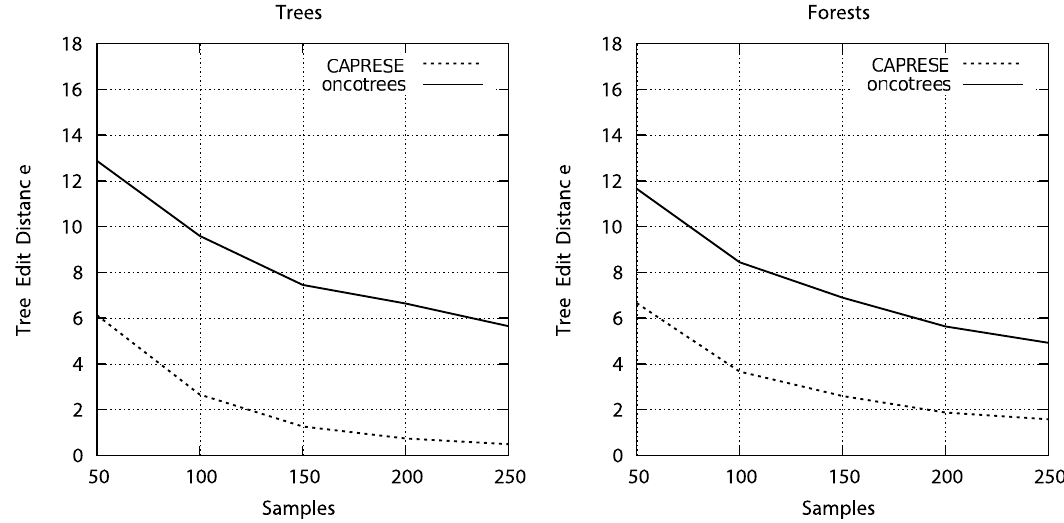
Figure 4. Comparison on noise-free synthetic data. Performance of CAPRESE (dashed line) and oncotrees (full line) in average TED when data are generated by random trees (left) and forests (right). In this case n ~ 0 (no false positives/negatives) and l ? 0 in the estimator m .